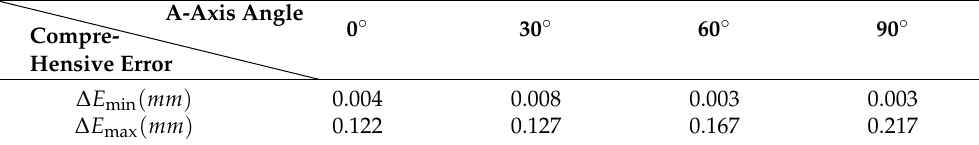
Table 4. The comprehensive error of the A-axis at each angle states when the C-axis = 0 ◦ . Compre-